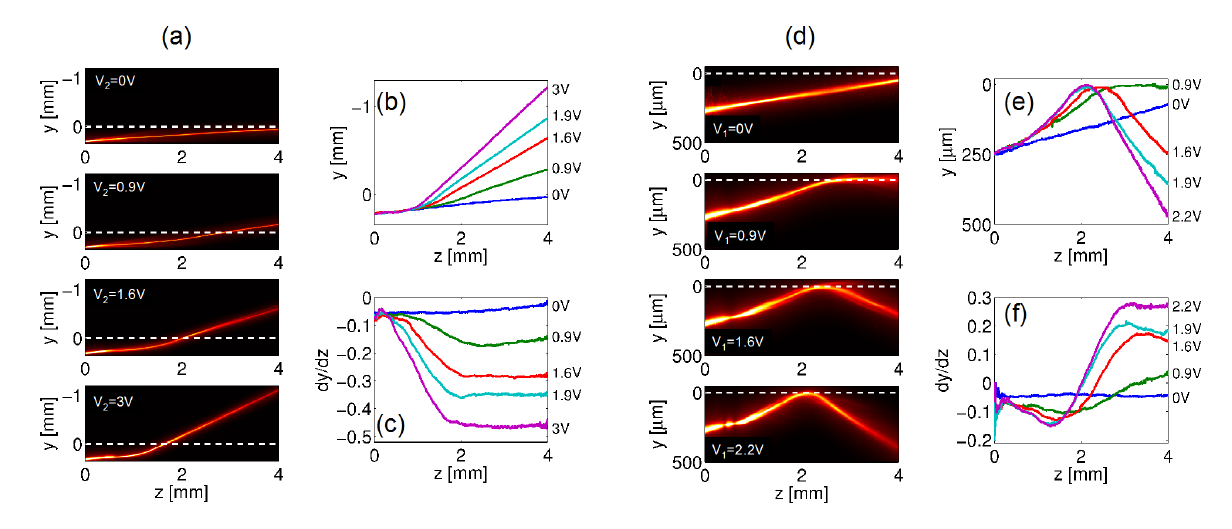
Figure 10. ( a ) Photographs of nematicon refraction at an interface defined by various values = 0 ; Corresponding graphs of ( b ) nematicon trajectory y = y ( z ) and ( c ) its of V when V 2 1 first derivative; ( d ) Photographs of nematicon total internal reflection at the graded interface, = 0 . Corresponding graphs of ( e ) nematicon trajectory in yz for various V , when V 1 2 and ( f ) its slope. Noteworthy, non-specular reflection can be observed, due to the optical anisotropy [35,36].